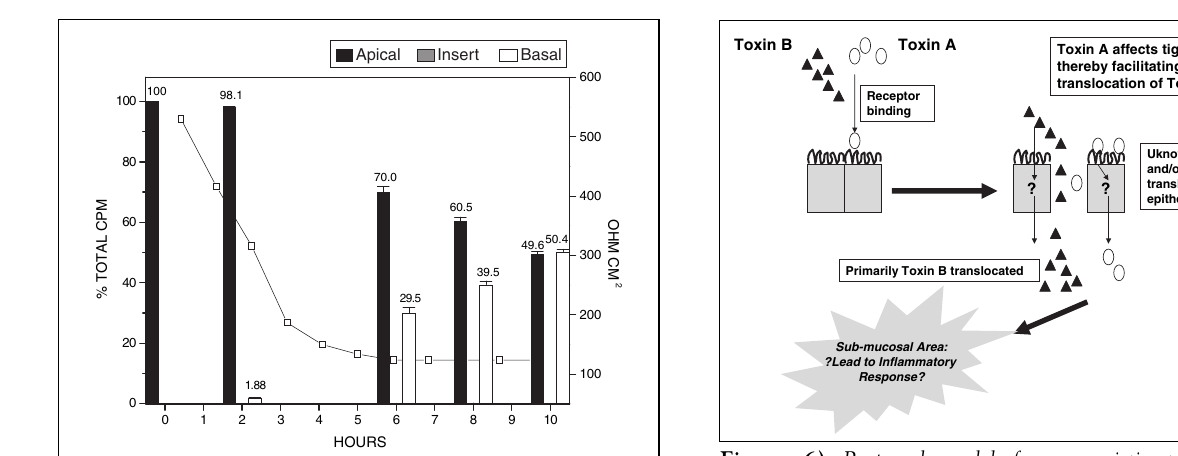
Figure 6) Proposed model for synergistic translocation of Clostridium difficile toxins A and B. Toxin A binds to epithelial cells and disrupts epithelial tight junctions. This allows both toxins to gain access to submucosal tissue to elicit an inflammatory response. Toxin B has enhanced ability to translocate compared with toxin